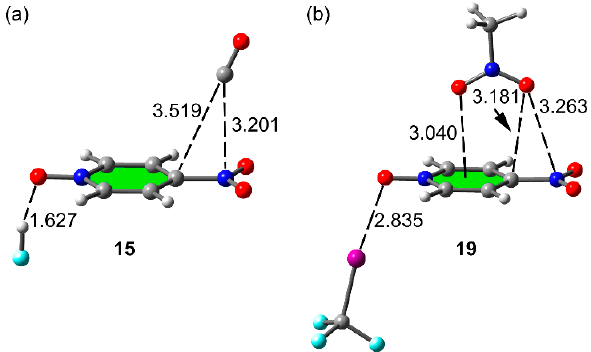
Figure 6. Optimized complexes 15 ( a ) and 19 ( b ). Distances in Å. The distance in parenthesis corresponds to the binary halogen bonded complex 8